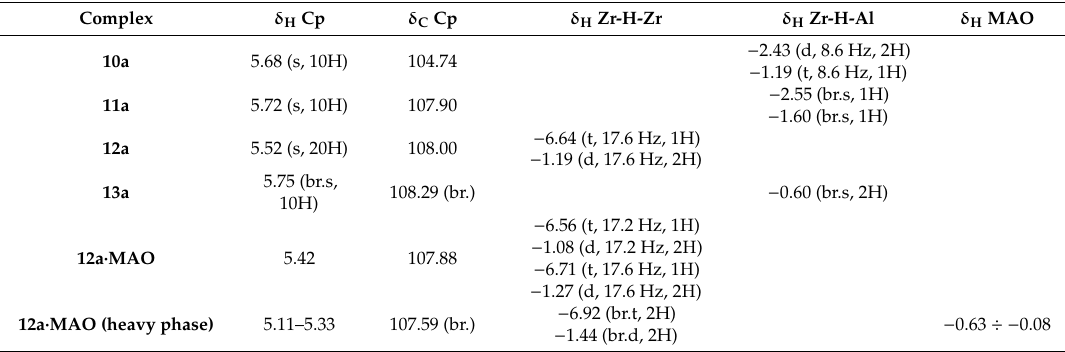
Table 3. 1 H and 13 C NMR of complexes 10a , 12a , 13a , 12a · MAO ( δ , ppm, 400.13 MHz, C 7 D 8 , T = 27 ◦